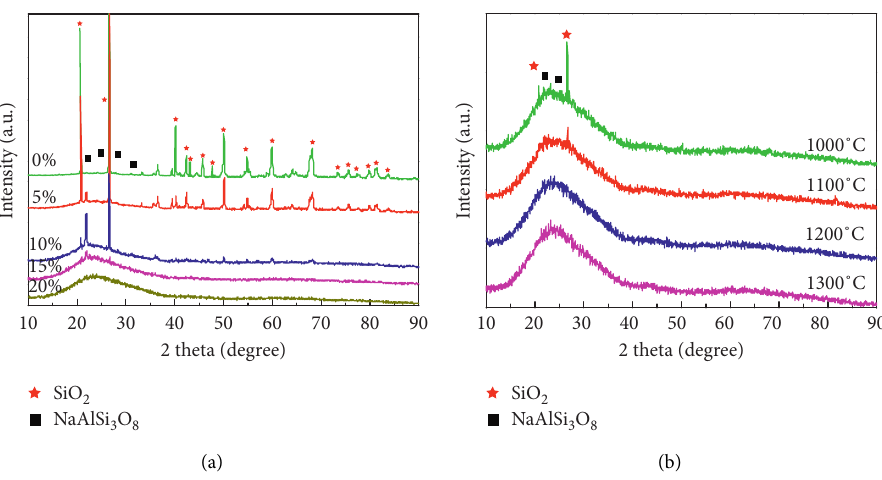
Figure 3: XRD patterns: (a) different Na 2 CO 3 contents and (b) different